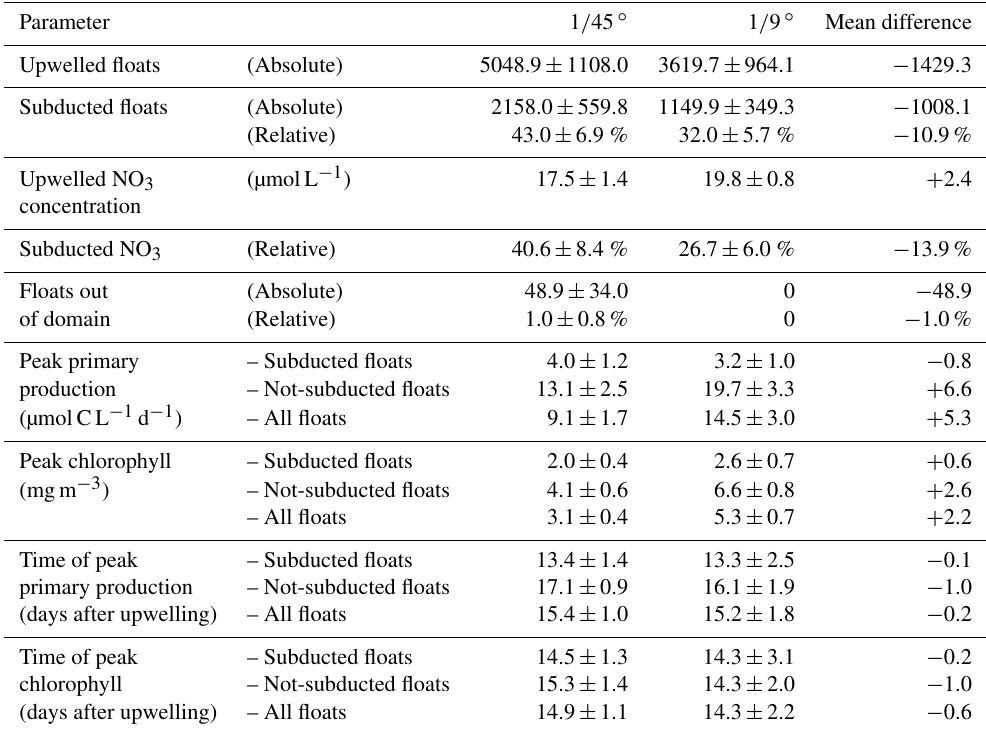
Table 2. Diagnosed variables from the virtual float ensembles in the 1 / 45 ◦ and 1 / 9 ◦ simulations. “Peak” values represent the maximum of the average over floats of one